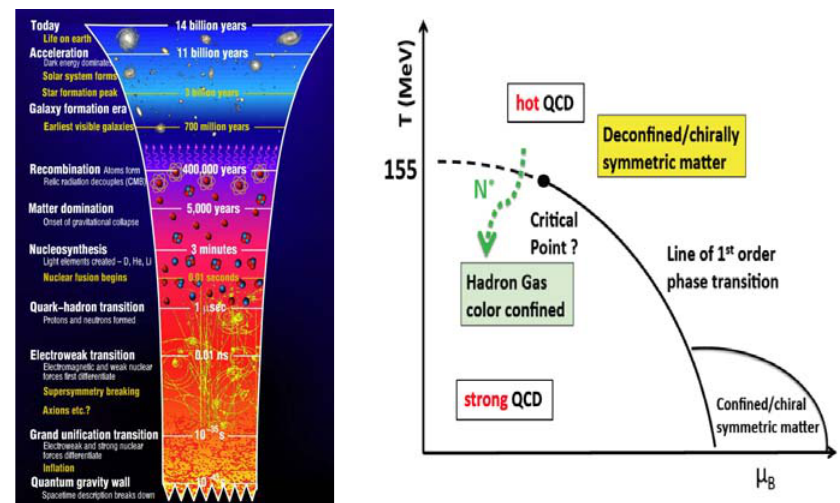
Fig. 1 Left panel: The evolution of the Universe. The line denoted as Quark-hadron transition , is where protons and neutrons are formed. Existing electron accelerators as CEBAF, ELSA, and MAMI, and colliders as BES III have sufficient energy reach to access this region and study processes in isolation that occurred during this transition in the microsecond old universe and resulted in the freeze out of baryons. Right panel: A generic phase diagram for the transition from the de-confined quark-gluon state to the confined hadron